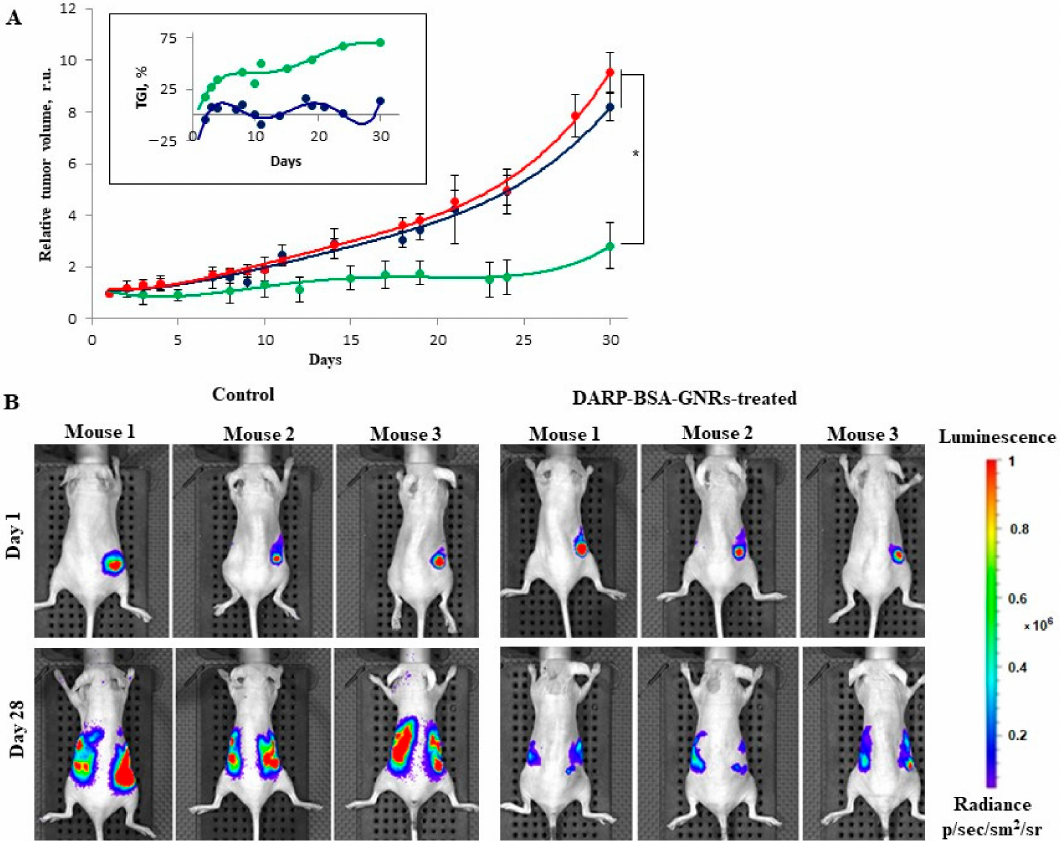
Figure 4. Effect of DARPin-BSA-GNRs on tumor growth dynamics in mice. ( A ) Mice were injected with PBS (red and blue curves) and DARPin-BSA-GNRs (green curve). The tumor areas in mice were illuminated by an NIR LED light source (blue and green curves). Bars indicate SD; * p < 0.05. Inset presents TGI value at every time point, calculated as described in the Materials and Methods section. ( B ) Imaging of BT474/NanoLuc tumor xenografts. The mice were injected with DARPin-BSA-GNRs (right panel) and PBS (left panel), illuminated by NIR light and imaged with an IVIS Spectrum CT system on the first (upper panels) and twenty-eighth (lower panels) days.